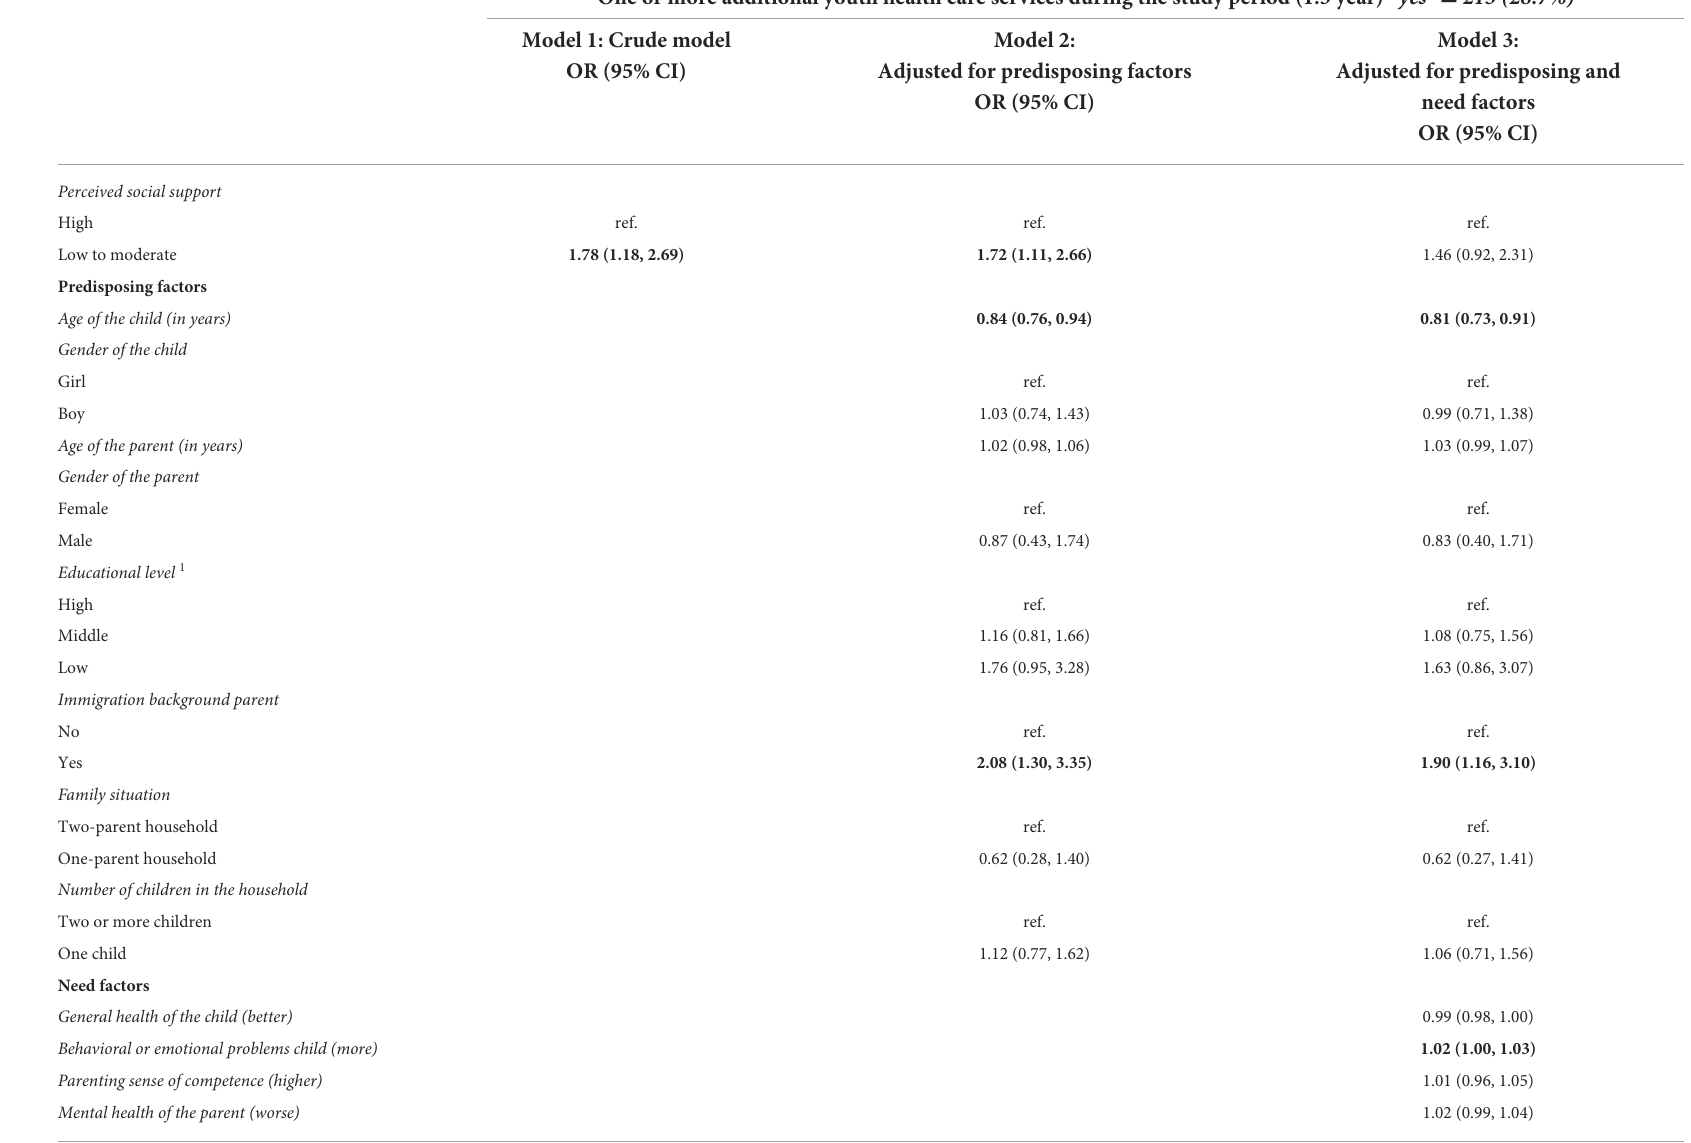
TABLE 2 Logistic regression models on the association between social support and the use of additional community youth health care services among parents of children aged 1–7 years participating in the CIKEO study ( n = 749).